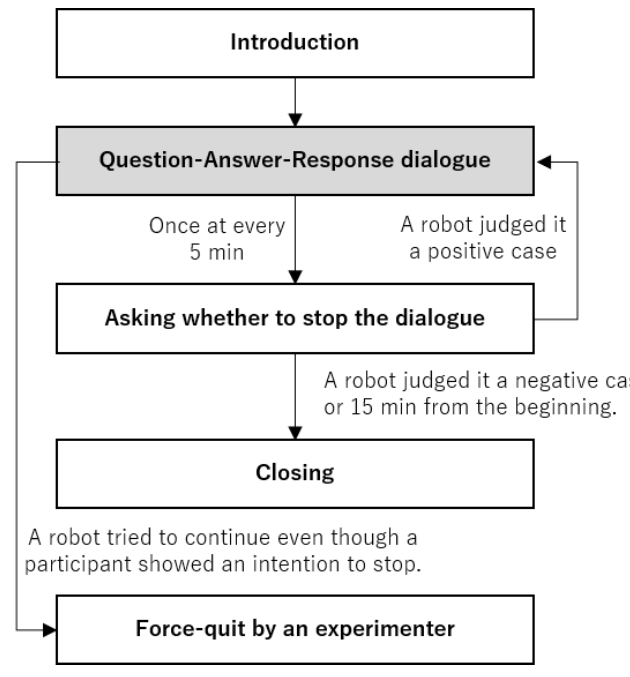
Figure 6. Flowchart of a dialogue in the